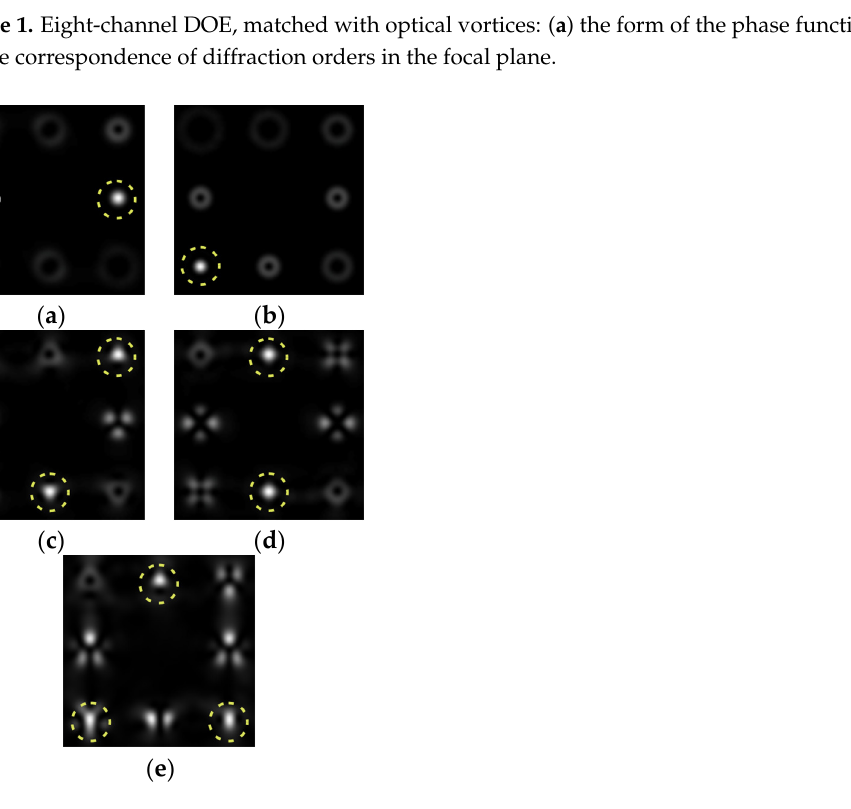
Figure 2. Action of an eight-channel DOE, matched with optical vortices in the analysis of vortex fields with homogeneous polarization: ( a ) m = 0, ( b ) m = − 1, ( c ) m = 1, − 2, ( d ) m = 2, − 2, and ( e ) m = − 1.2, − 3. Table 1. Code correspondence of diffraction order numbers to the presence of phase vortices in the analyzed beam for a homogeneous polarization